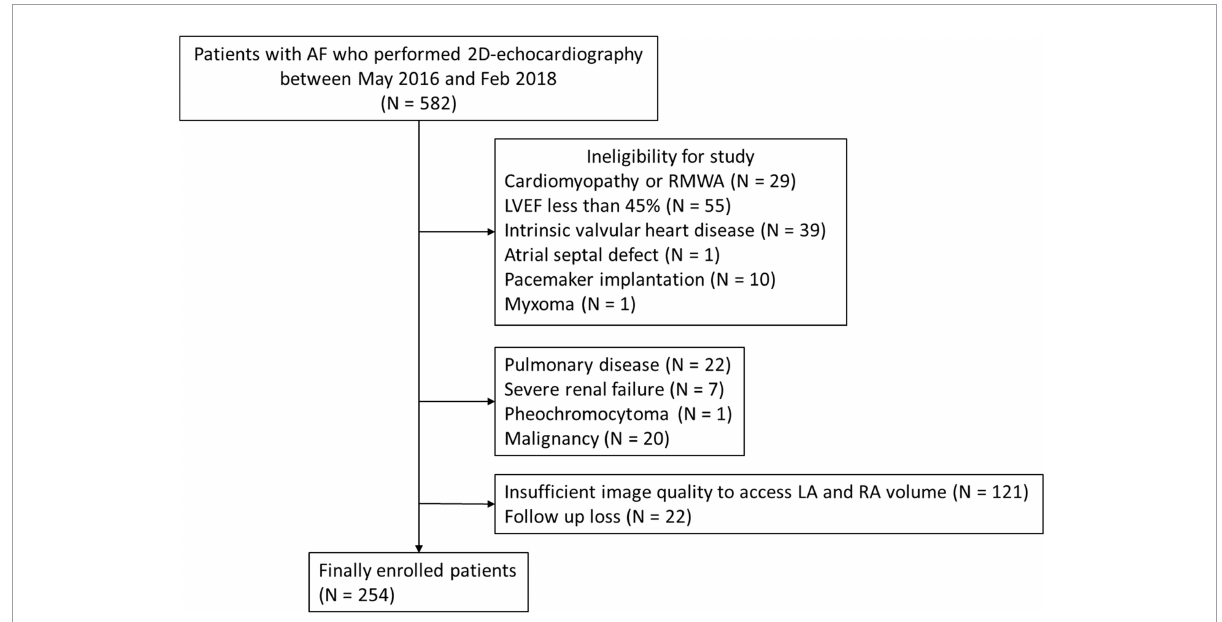
FIGURE1 Study flow chart. AF, atrial fibrillation; LA, left atrium; LVEF, left ventricular ejection fraction; RA, right atrium; RWMA, regional wall motion abnormality.